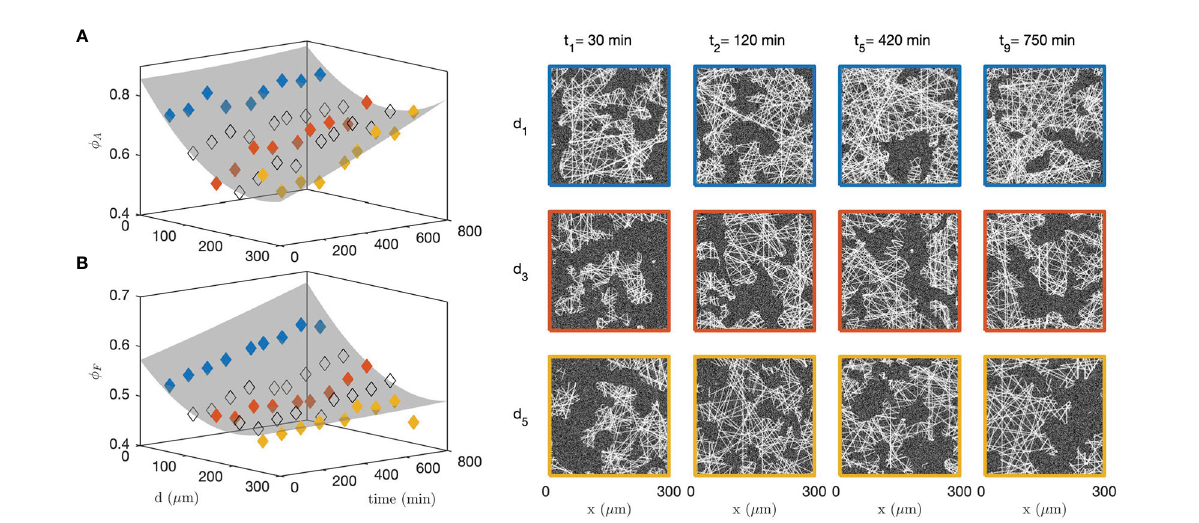
FIGURE 10 Fitted collagen structure for various times and distances to the CAF cells, with aggregate density f A (A) and fi bre density within the aggregates f F (B) . The grey surface is a guide to the eye. Speci fi c realizations are shown on the right panel to illustrate the signi fi cance of the parameters. The colour code for distances is the same as in Figure 9; the non-colored symbols point to intermediate distances not shown in Figure